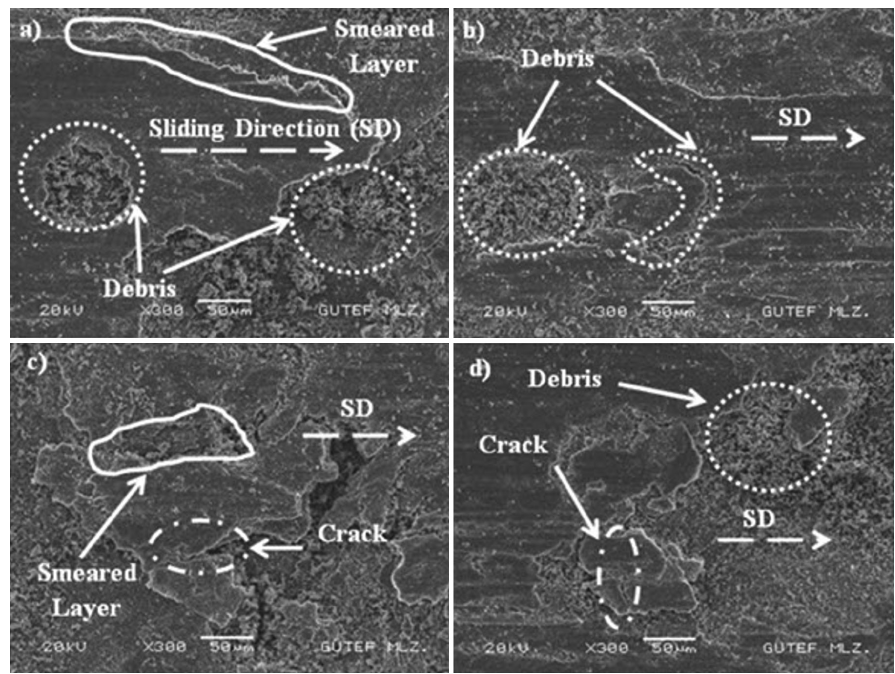
Figure 7. In 550 °C temperature, abraded surface SEM images of A356+6% Ti AMCs synthesized for 1 (a), 4 (b), 8 (c) and 16